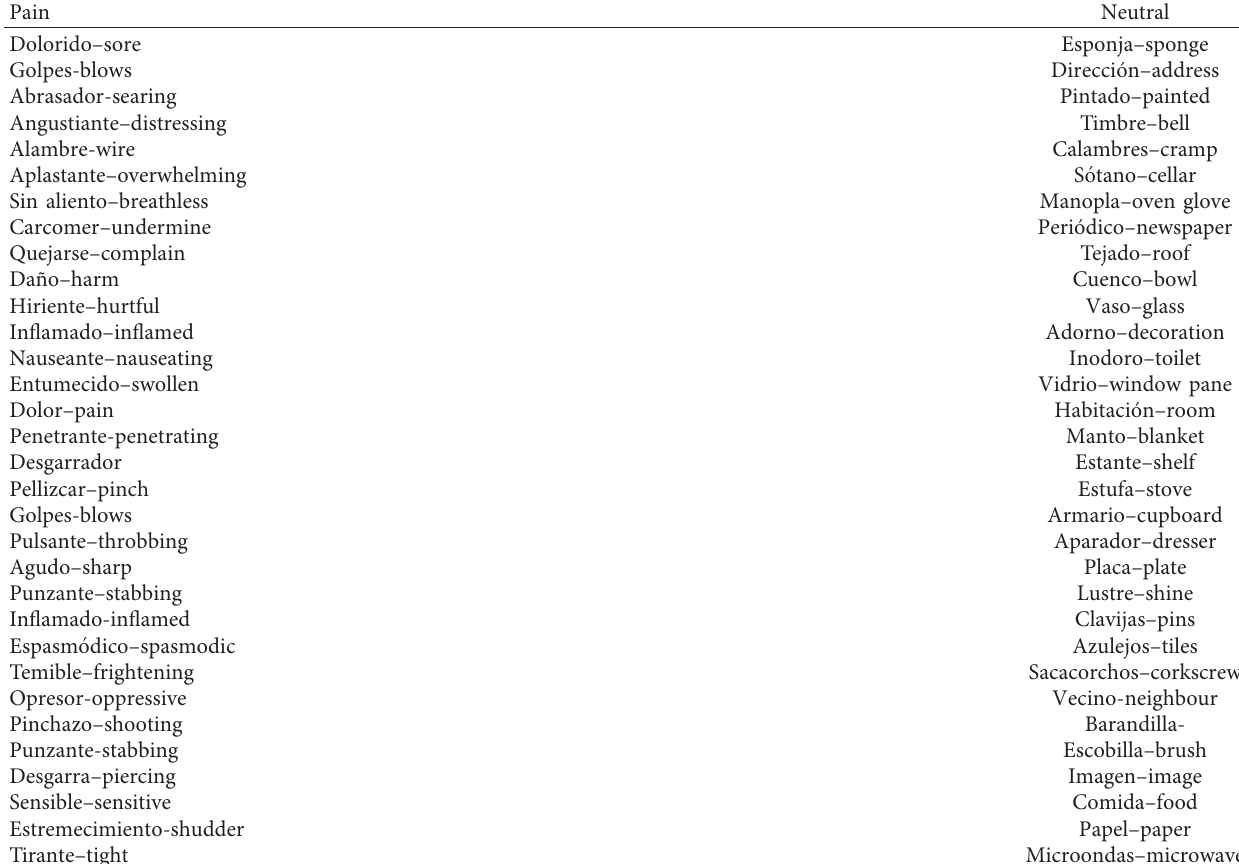
Table 1: List of words used in the dot-probe